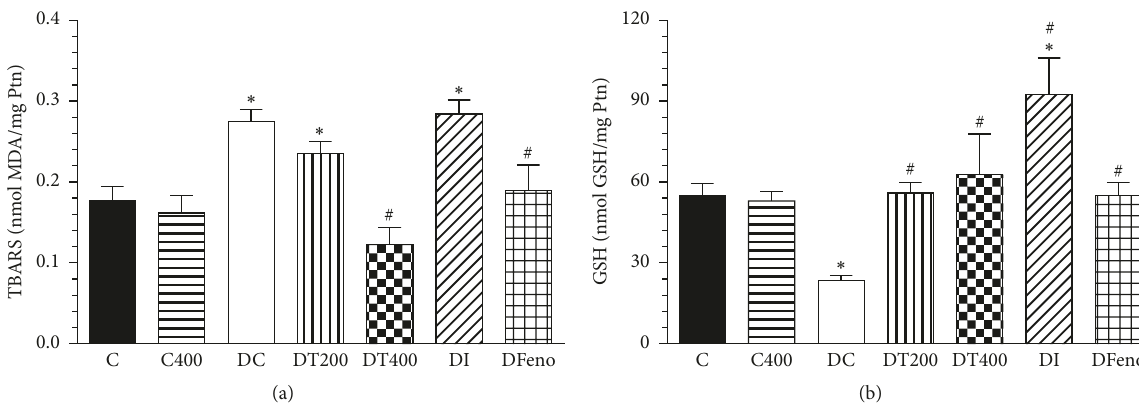
Figure 5: Effects of the EEMn on malondialdehyde (MDA) (a) and reduced glutathione (GSH) (b) levels after 14 days of experiment. C, nondiabetic control; CT400, nondiabetic control rats treated with 400 mg/Kg of EEMn; DC, diabetic control; DT200, diabetic rats treated with 200 mg/Kg of EEMn; DT400, diabetic rats treated with 400 mg/Kg of EEMn; DI, diabetic rat treated with insulin (3U/rat); DFeno, diabetic rat treated with fenofibrate (150mg/Kg). Ptn, protein. Each point represents the means ± SEM of 6–8 animals. ∗ 𝑃 < 0.05 versus C; # 𝑃 < 0.05 versus